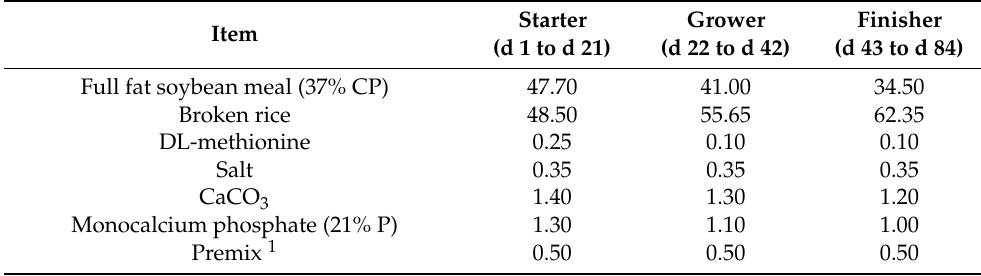
Table 1. Compositions and calculated nutrient contents of starter, grower, and finisher diets (g/100 g diet, as-fed